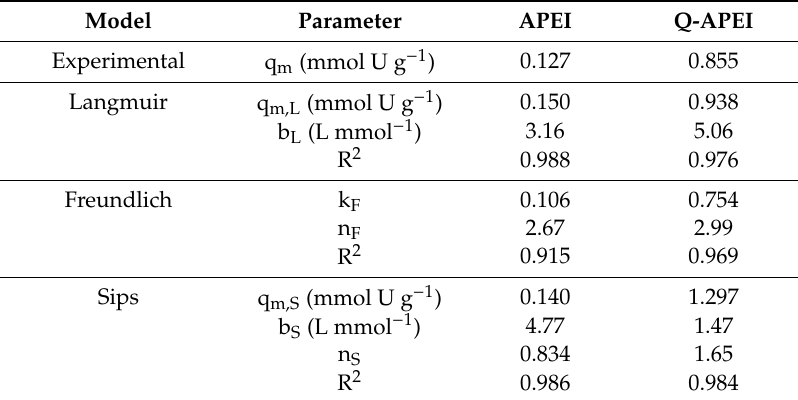
Figure 5. U(VI) sorption isotherms at pH 4 using APEI and Q-APEI—Modeling with the equations of Langmuir, Freundlich, and Sips (SD: 0.375 g L −1 ; pH 0 : 4; pH eq : 3.87–3.69 for Q-APEI and 4.19–3.97 for APEI; C 0 : 0.04–2.13 mmol U L −1 ; agitation speed: 170 rpm; contact time: 48 h; T: 22 ± 2 °C). Table 2. Parameters of models for U(VI) sorption isotherms.